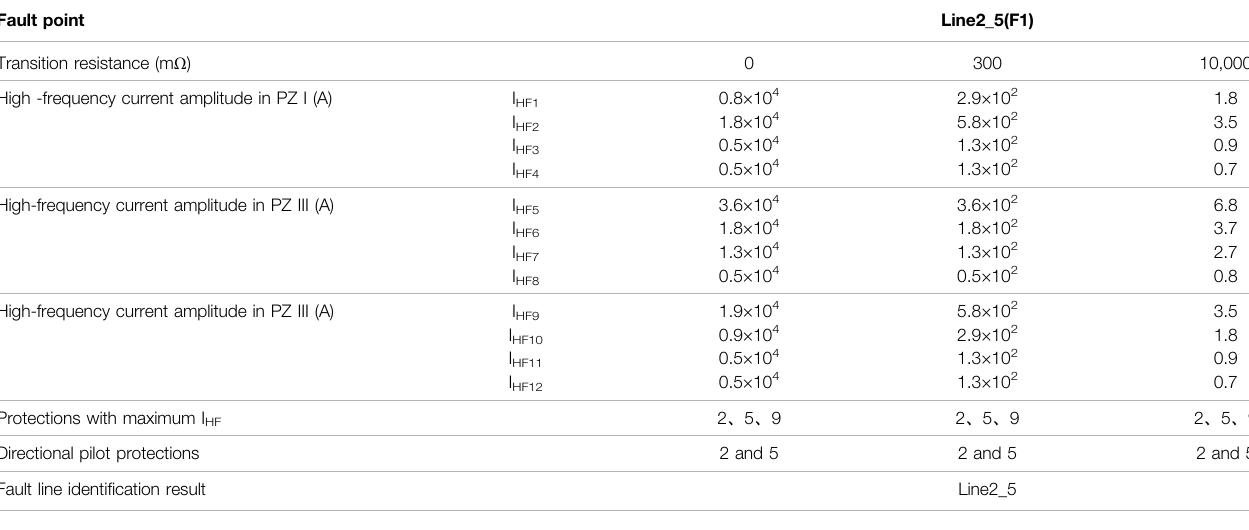
TABLE 2 | Fault simulation results of Line2_5.